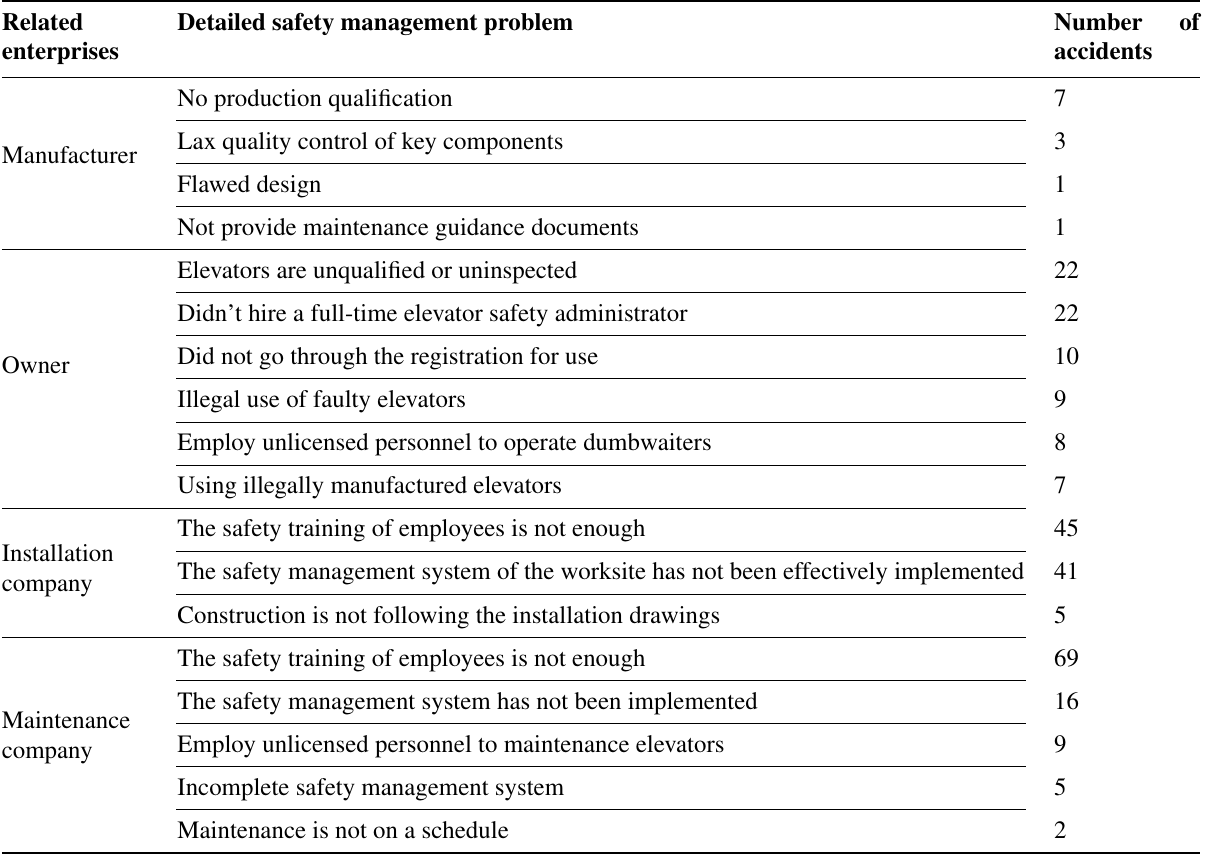
Table 7 Safety management-related